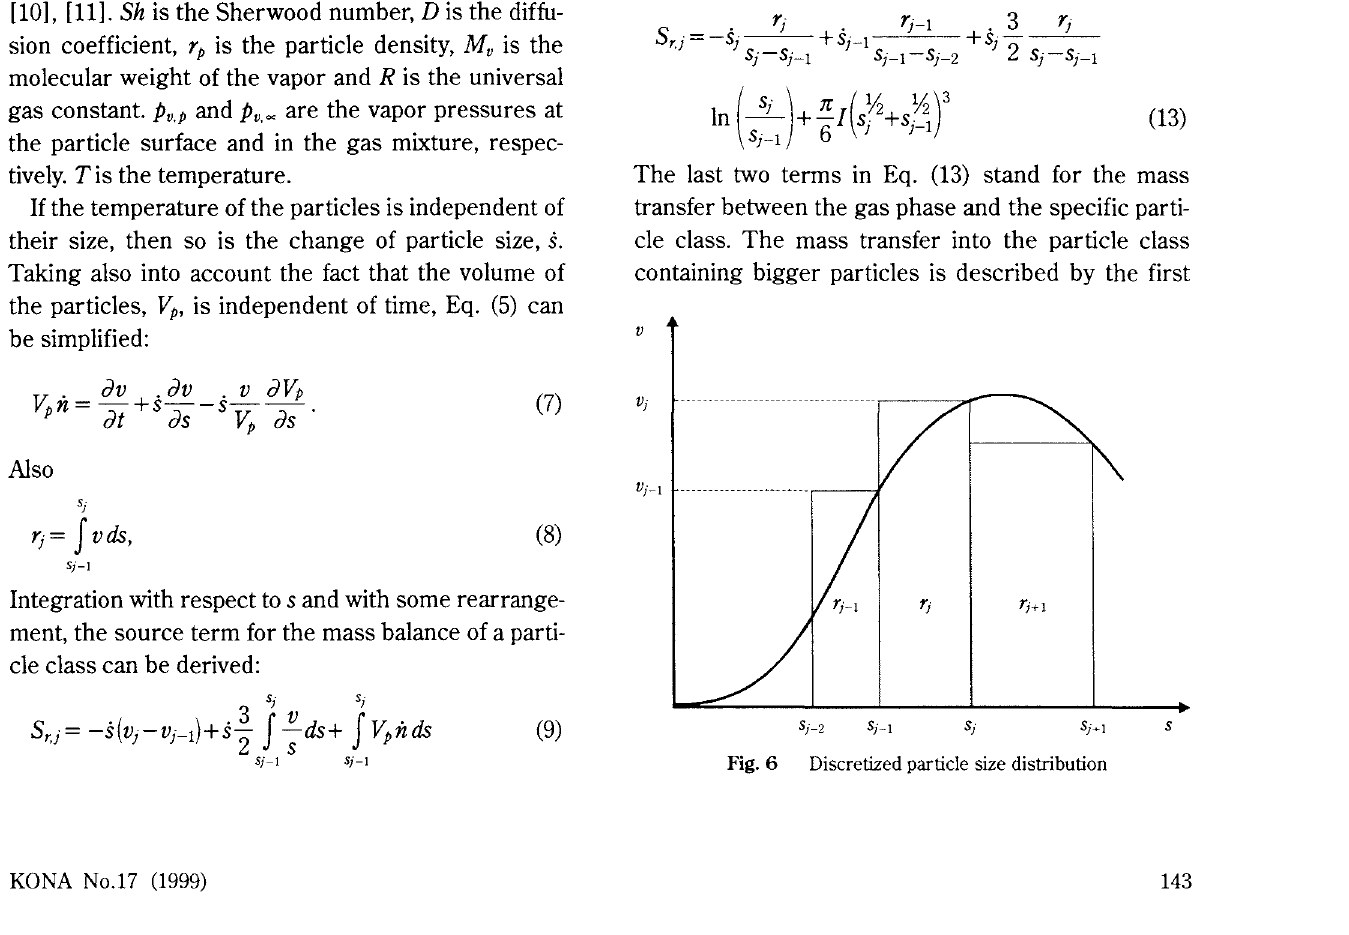
Fig.6 Discretized particle size